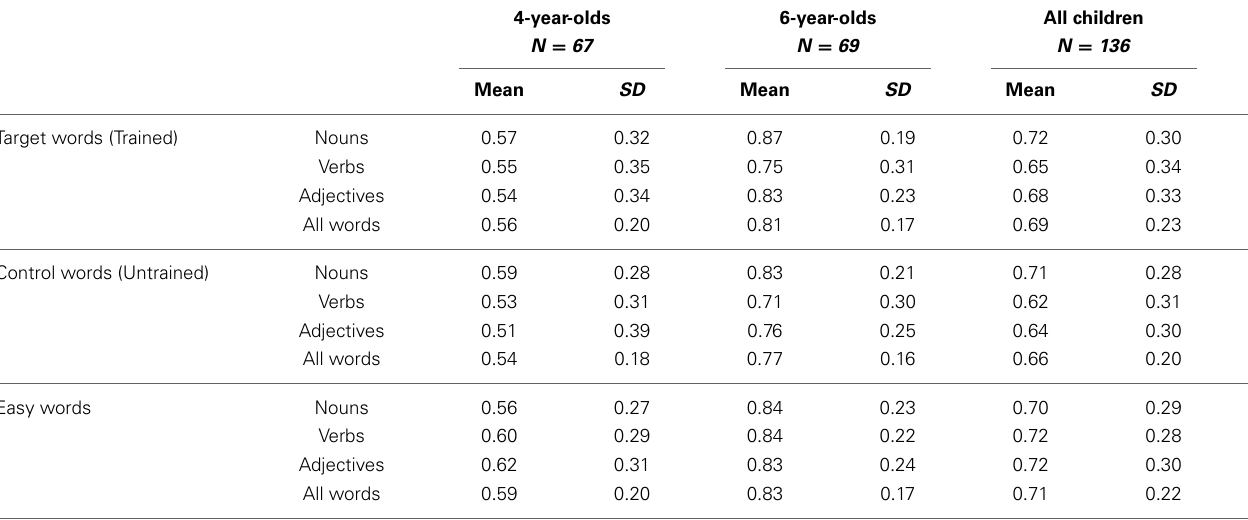
Table 3 | Mean proportion of correct responses for each set of words in the grammaticality judgment